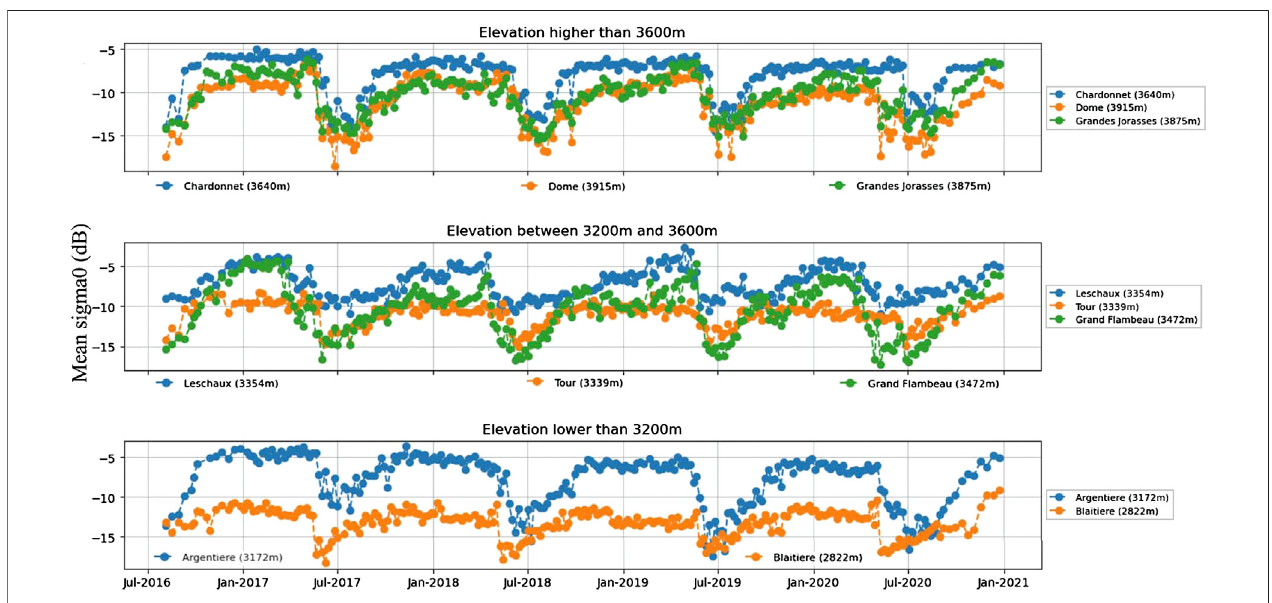
FIGURE 7 | Temporal backscattering pro fi le for 8 visible IAs using Sentinel-1 images (2016 – 2020).